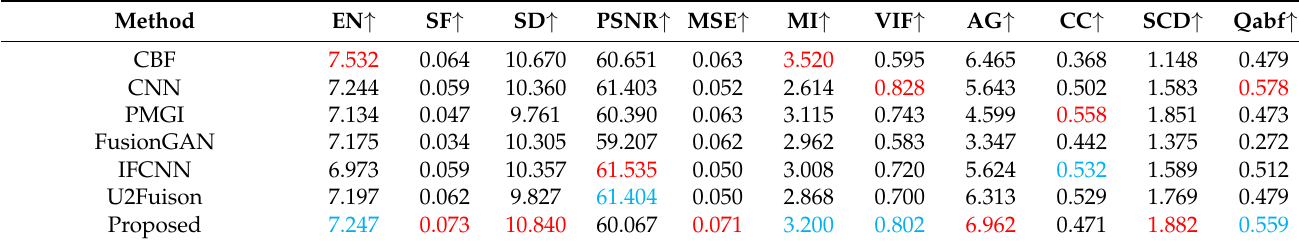
Table 6. The objective experimental results of different fusion methods show that red font is optimal and blue font is